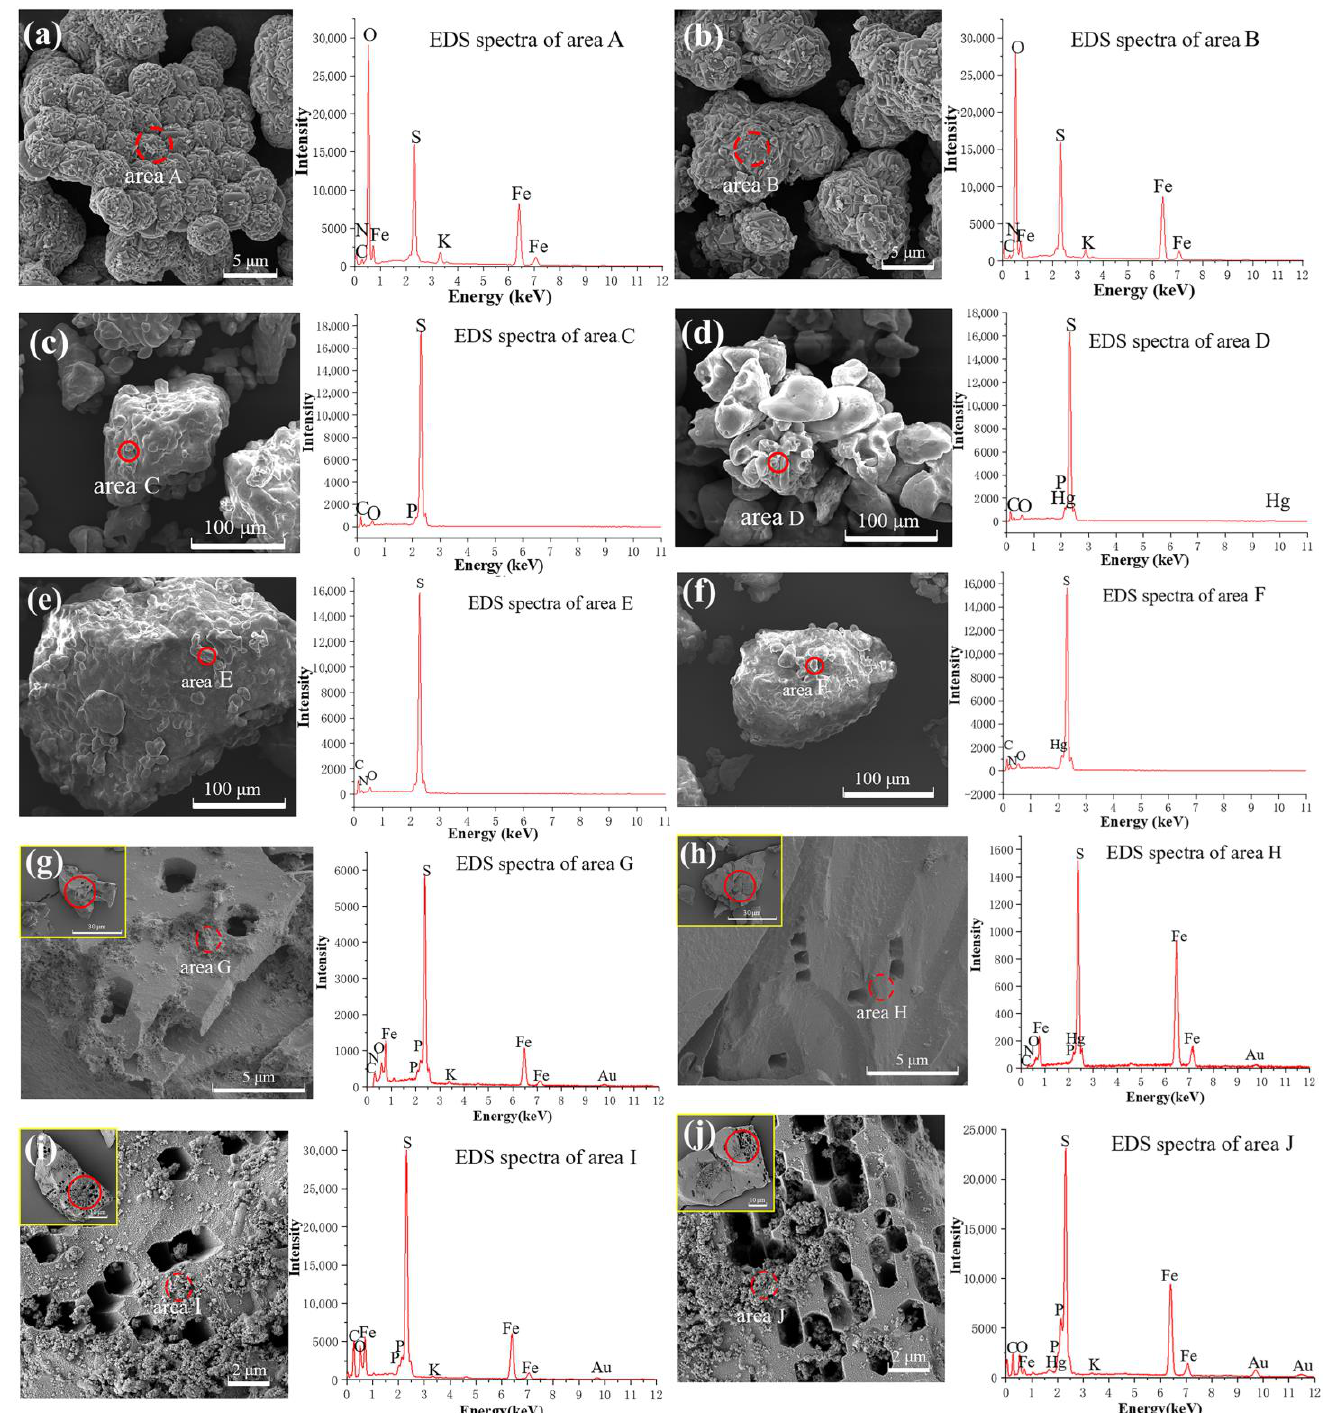
Figure 4. SEM-EDS images of bacterial cells for A. ferrooxidans ATCC 23270 in the presence of Hg 2+ .